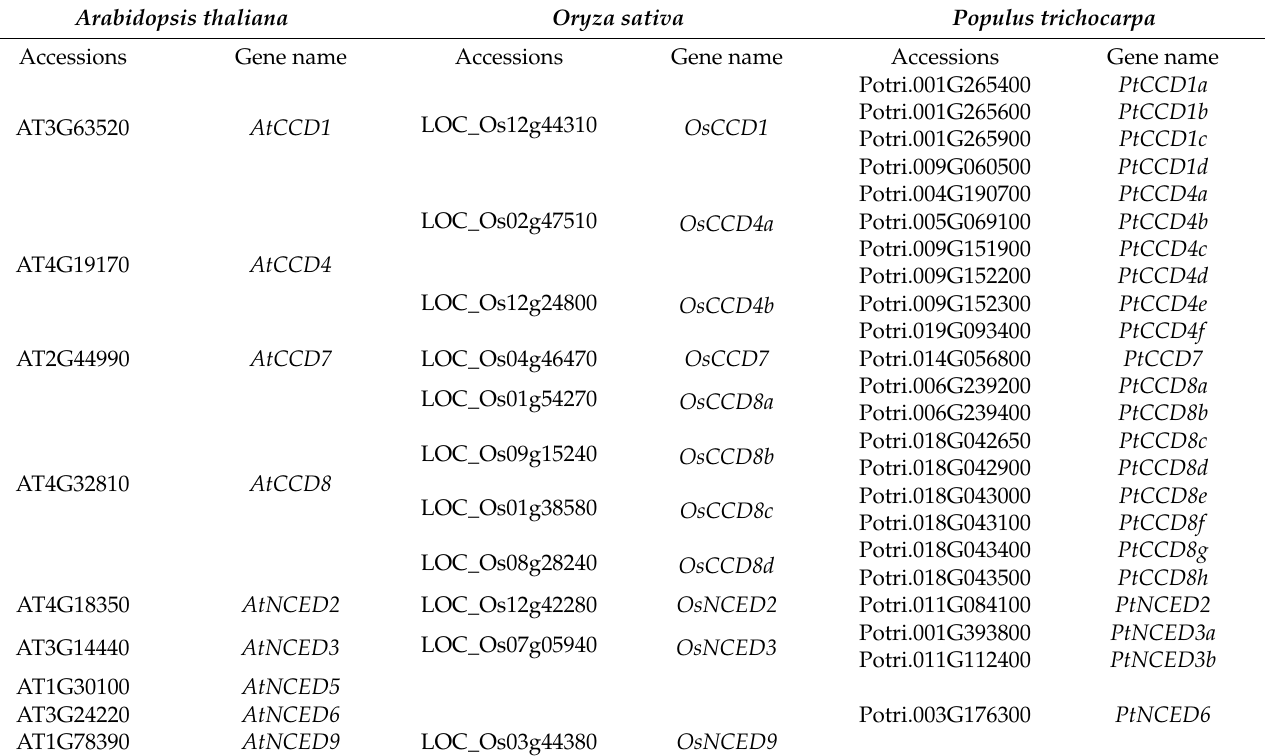
Table 1. The poplar, Arabidopsis, and rice CCD accession numbers and gene